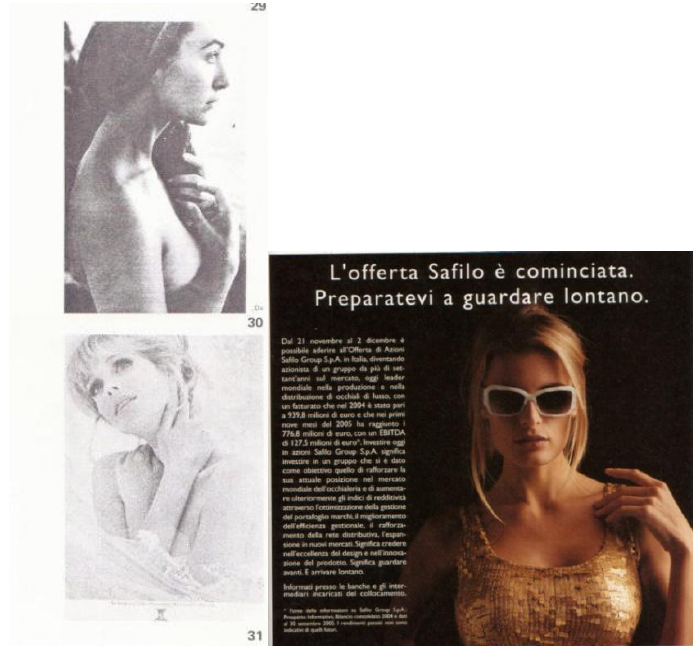
Figure 2. Goffman’s picture and selected picture, self touch.